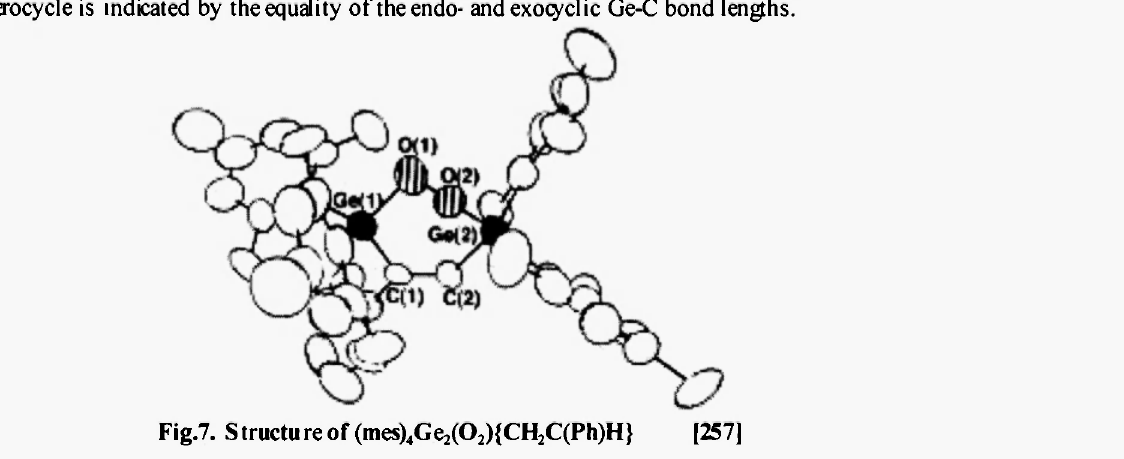
Fig.7. Structure of (mes) 4 Ge 2 (0 2 ){CH 2 C(Ph)H}